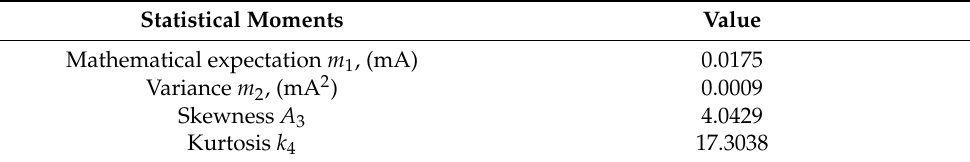
Table 1. Statistical moments of signal. Statistical